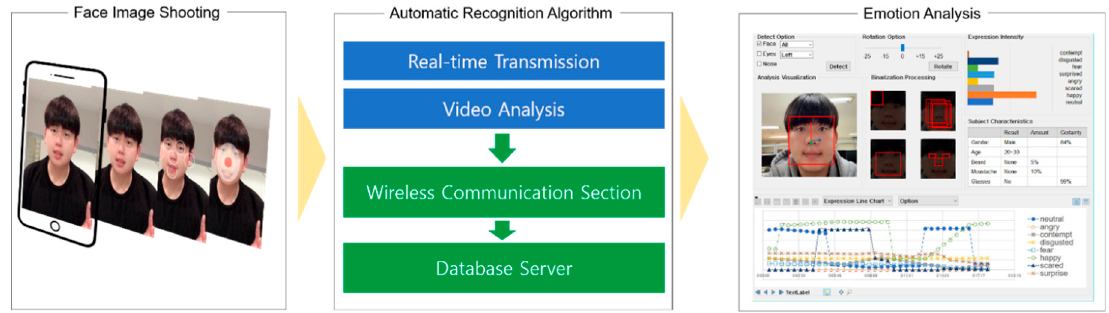
Figure 15. The structure of the interview management system. * The figure included in this image is the author, who agreed to provide the